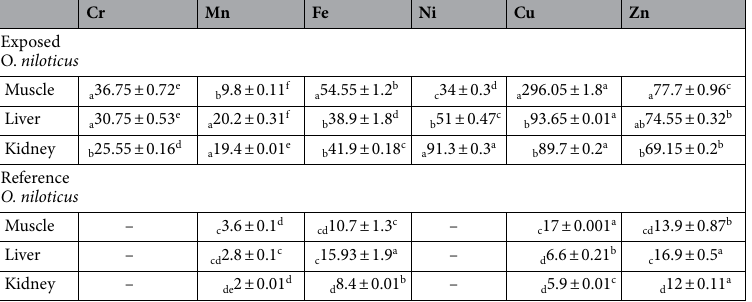
Table 1. Heavy metal concentrations in fish tissues (mg/kg. dw). All values are given as mean ± SEM (n = 15); Two way ANOVA and DMRT was used for statistical analysis. Means with similar letters (superscripts and subscripts) along the column and row are statistically similar at p < 0.05; Blank cells indicate below detection